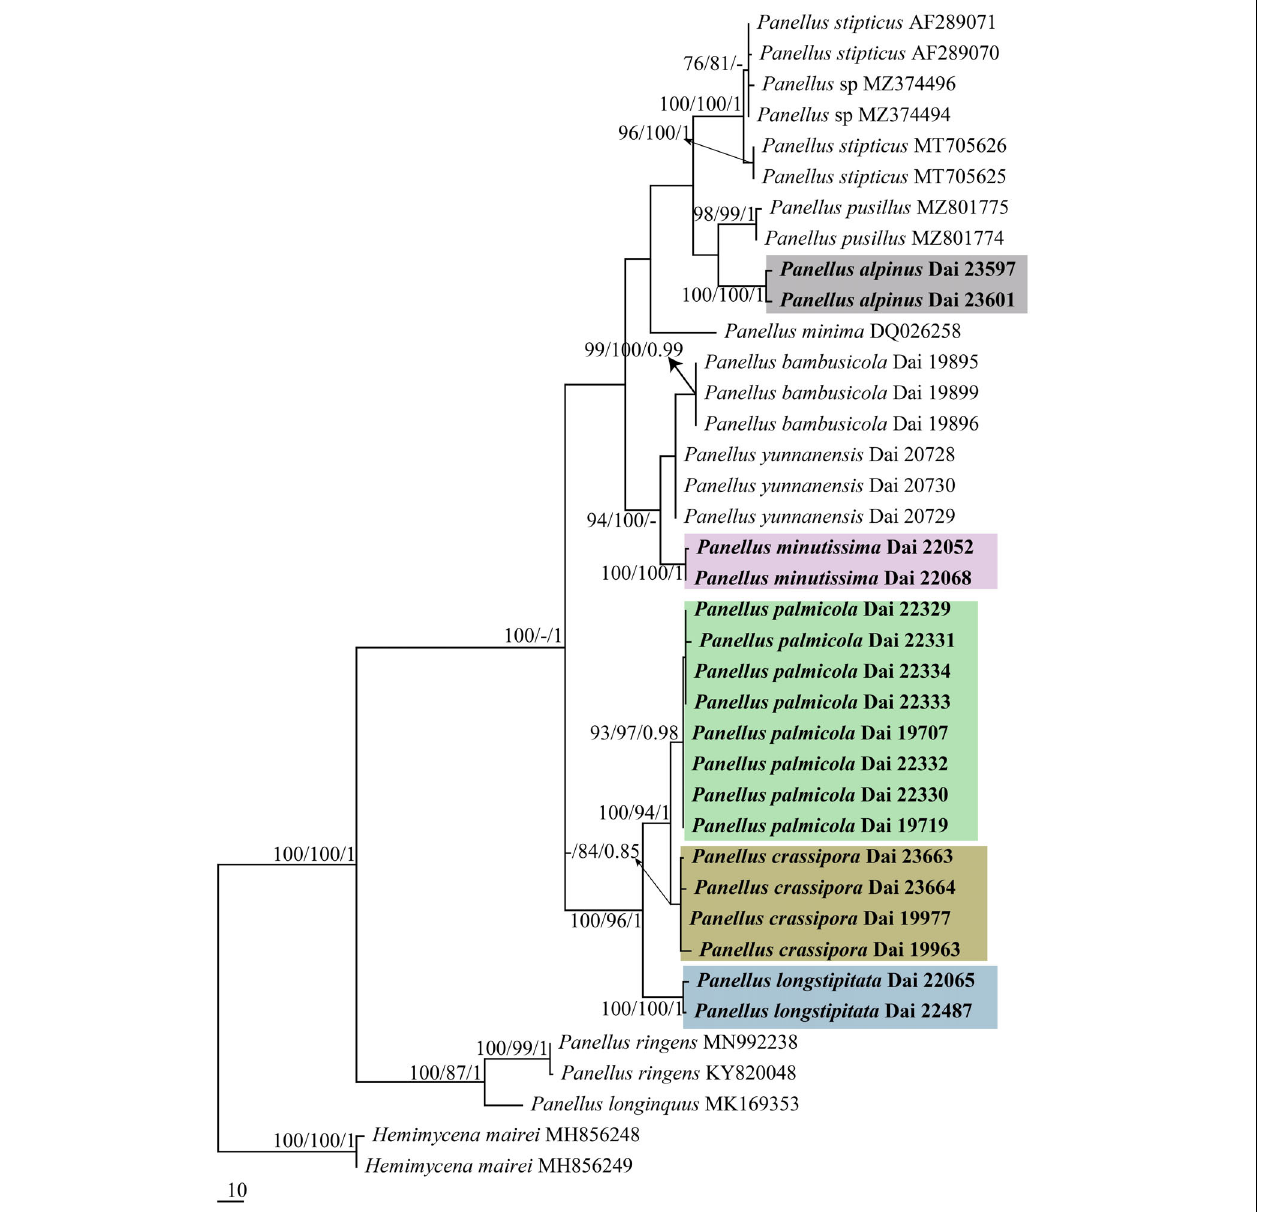
FIGURE 1 | Maximum parsimony (MP) tree illustrating the phylogeny of Panellus based on nrITS dataset. Branches are labeled with parsimony bootstrap values (MP/ML) higher than 75%, and Bayesian posterior probabilities (BPPs) more than 0.95. The five colors represent the five new species in this paper, respectively.